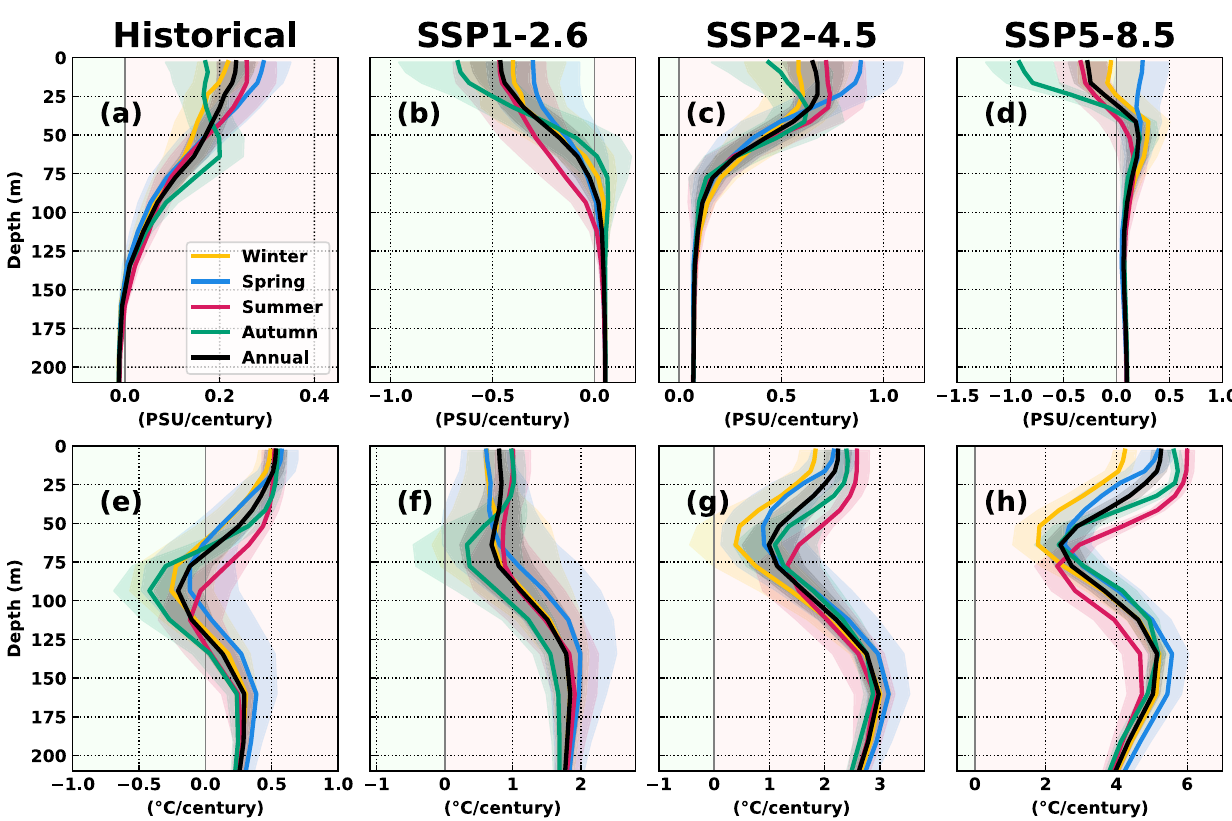
Fig. 4 Trend in the temperature and salinity pro fi les. The vertical pro fi les of a linear trend in ( a – d ) salinity and ( e – h ) temperature in ( a , e ) Historical, b , f SSP1-2.6, c , g SSP2-4.5, and ( d , h ) SSP5-8.5 scenarios. The shaded region indicates the 95% con fi dence